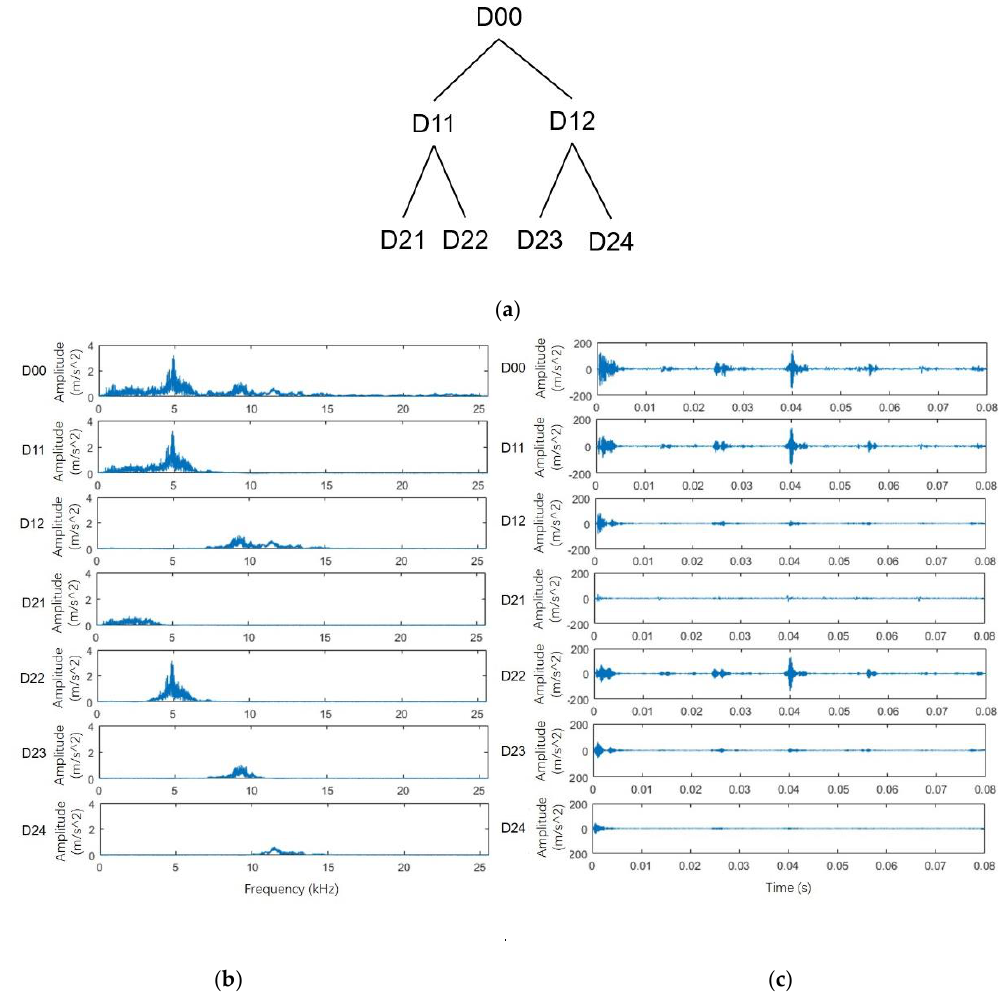
Figure 4. The spectrum and mode obtained by VMD (Variational Mode Decomposition) in fault 4 condition: ( a ) VMD decomposition tree ( b ) spectrum ( c ) mode.